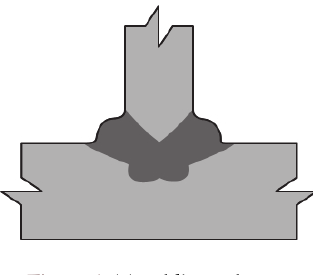
Figure 1: T welding scheme. Figure 2: Tilt angle of the laser beam during welding.